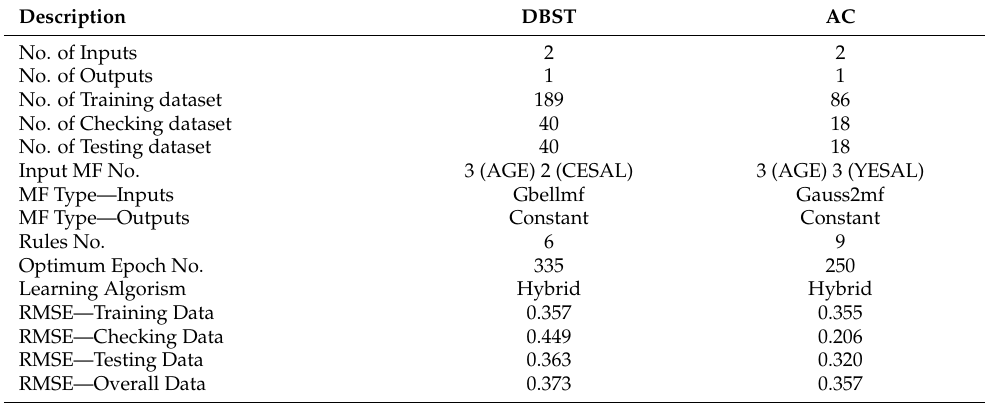
Table 4. The full description of the optimum ANFIS models for DBST and AC pavement sections.